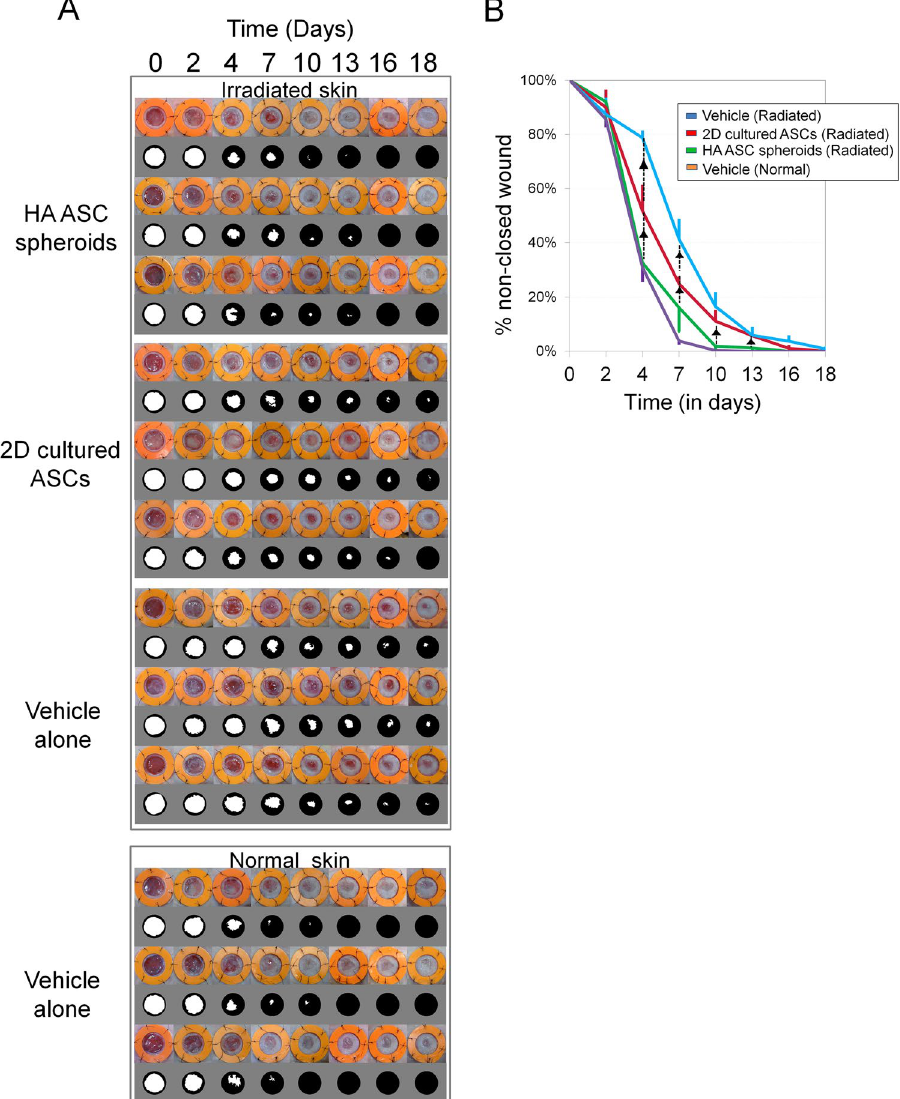
Figure 5. Macroscopic evaluation of wound healing in irradiated tissue of nude mice. ( A ) Sequential views of cutaneous ulcers (8 mm in diameter) treated with different cellular products or vehicle in irradiated or normal skin. The inner diameter of the splint was 14 mm. ( B ) Quantification of wound healing at different time points. n = 3 mice; p day4 = 0.0249, p day7 = 0.0249, p day13 = 0.0330, p day16 = 0.0364. ▲ Represent p <